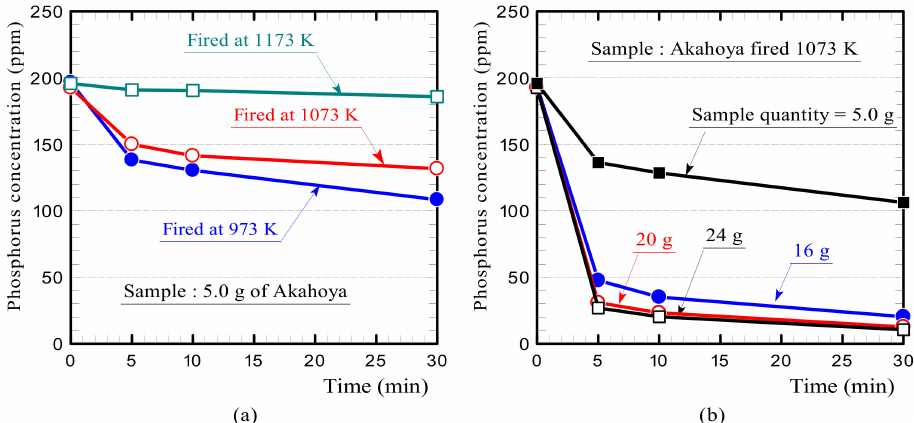
Figure 17. Changes in the phosphorus concentration of the aqueous solution containing Akahoya samples according to the ( a ) firing temperature and ( b ) sample amount.